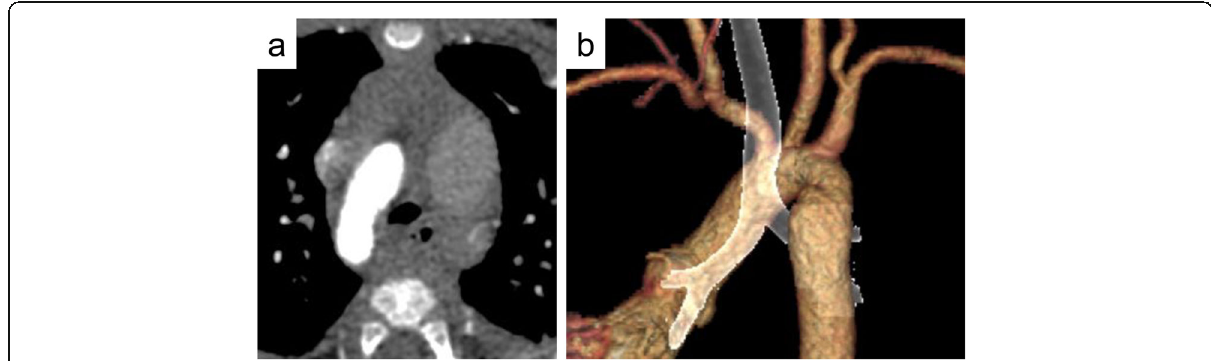
Fig. 2 Chest CT at postoperative status describing the release of tracheal compression. a Horizontal image in chest CT. b 3D image from the left back in chest